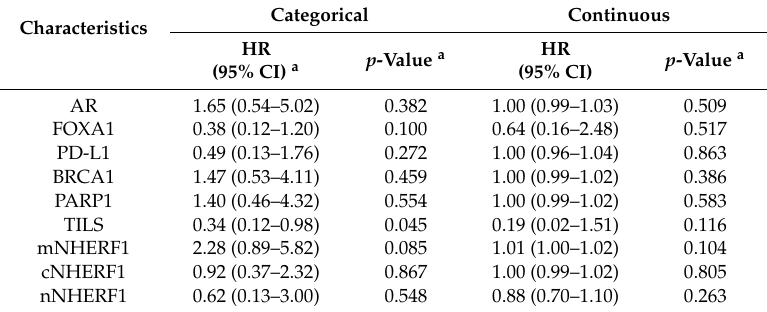
Table 3. DFS multivariate analysis on categorical and continuous